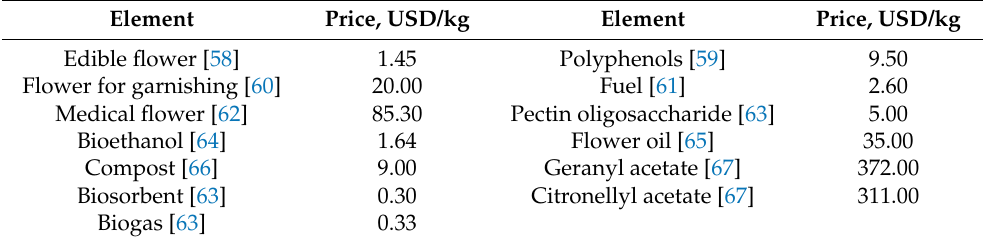
Table 8. Product cost for upgrading